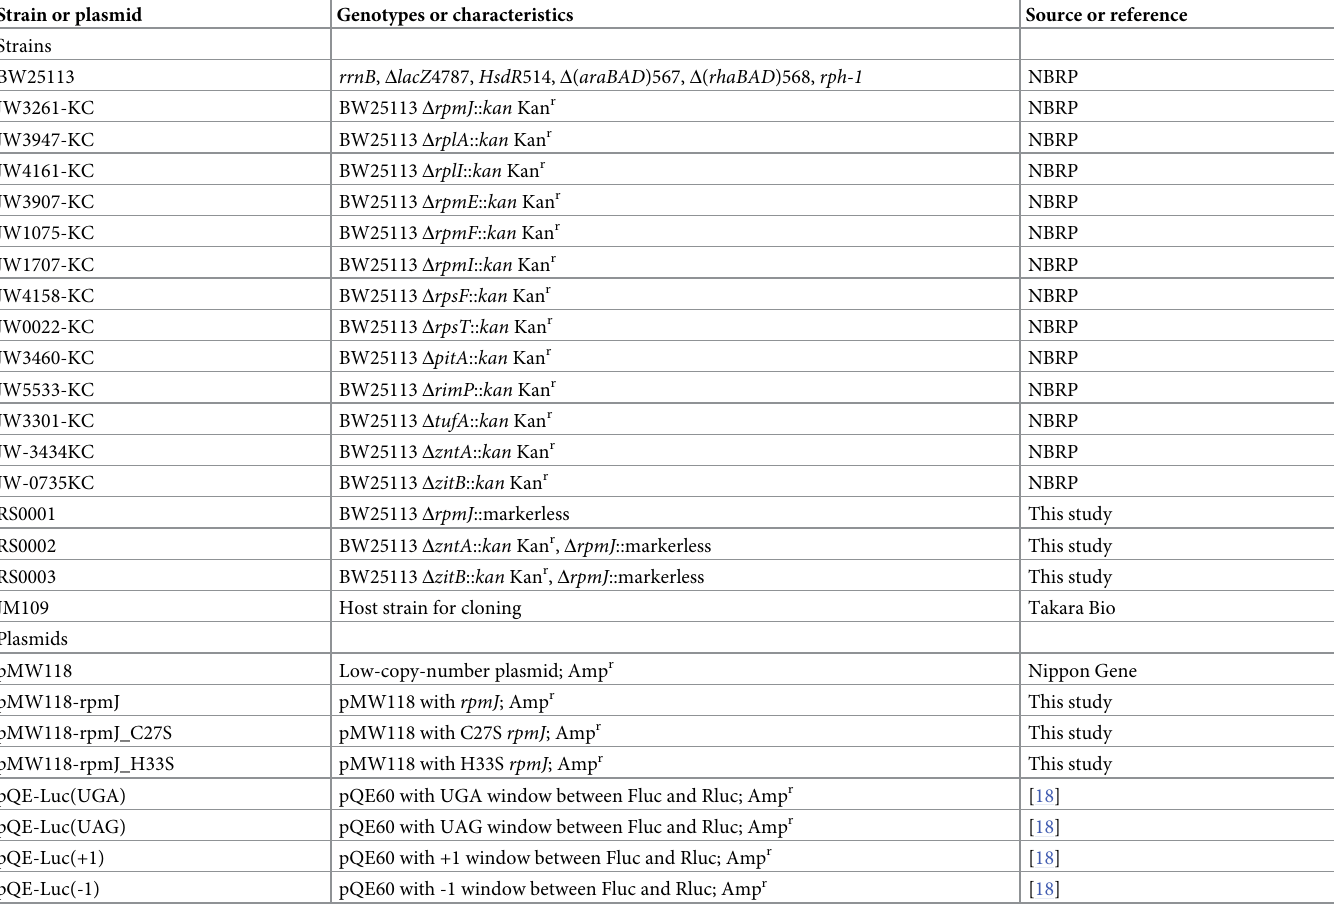
Table 2. List of bacterial strains and plasmids used. Strain or plasmid Genotypes or characteristics Source or